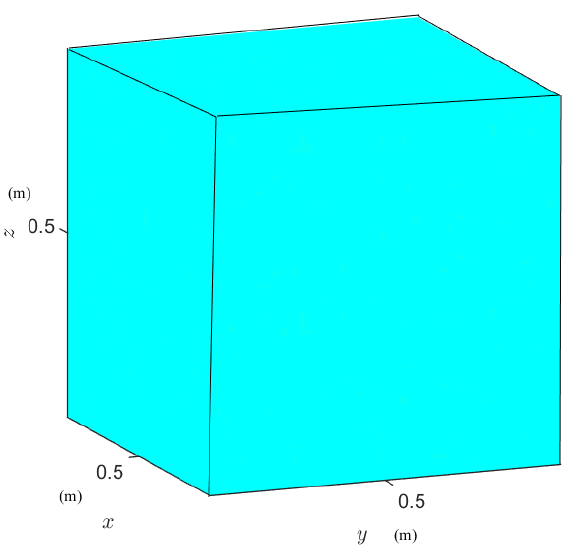
Figure 13. Computational domain.